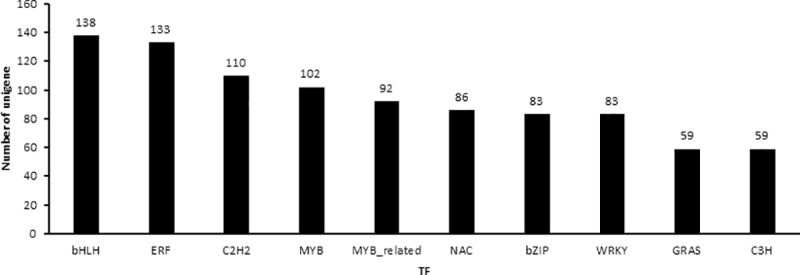
Main Type classification of predicted TF.The horizontal coordinates are the main type of TF, and the vertical coordinates are the numbers of unigene in one TF class.